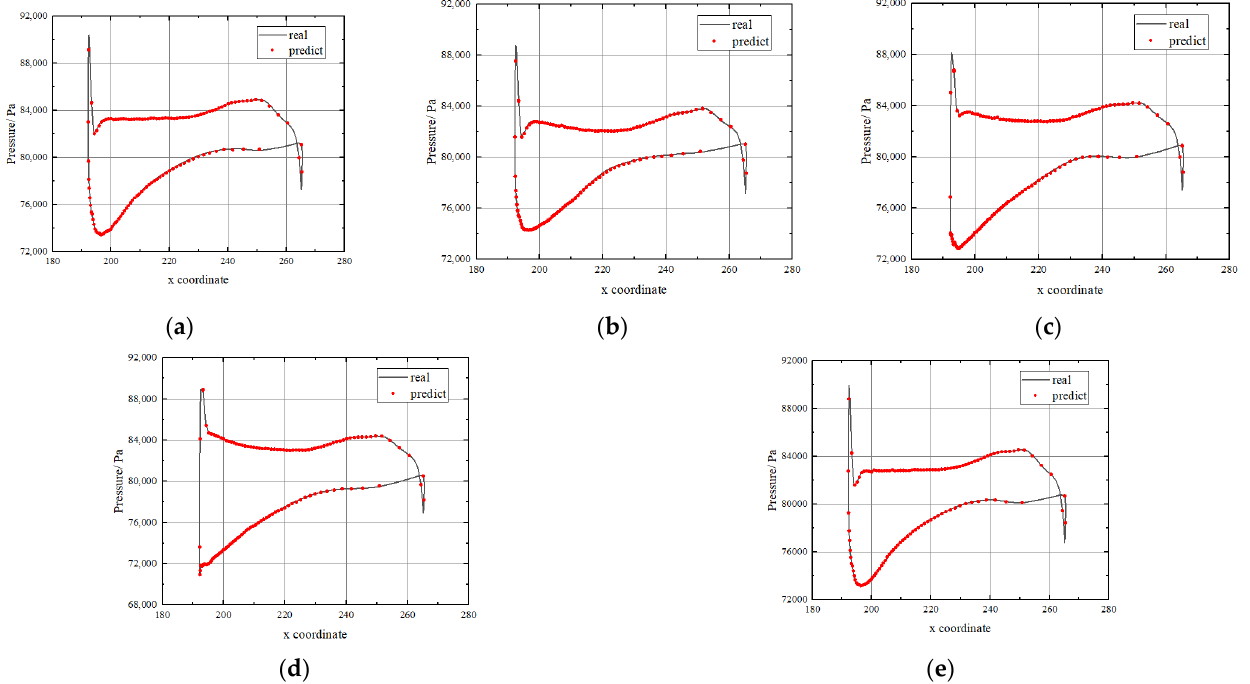
Figure 8. Unsteady pressure on stator surface at 10% span. ( a ) t = 0. ( b ) t = 1/4T. ( c ) t = 1/2T. ( d ) t =3/4T. ( e ) t = T.